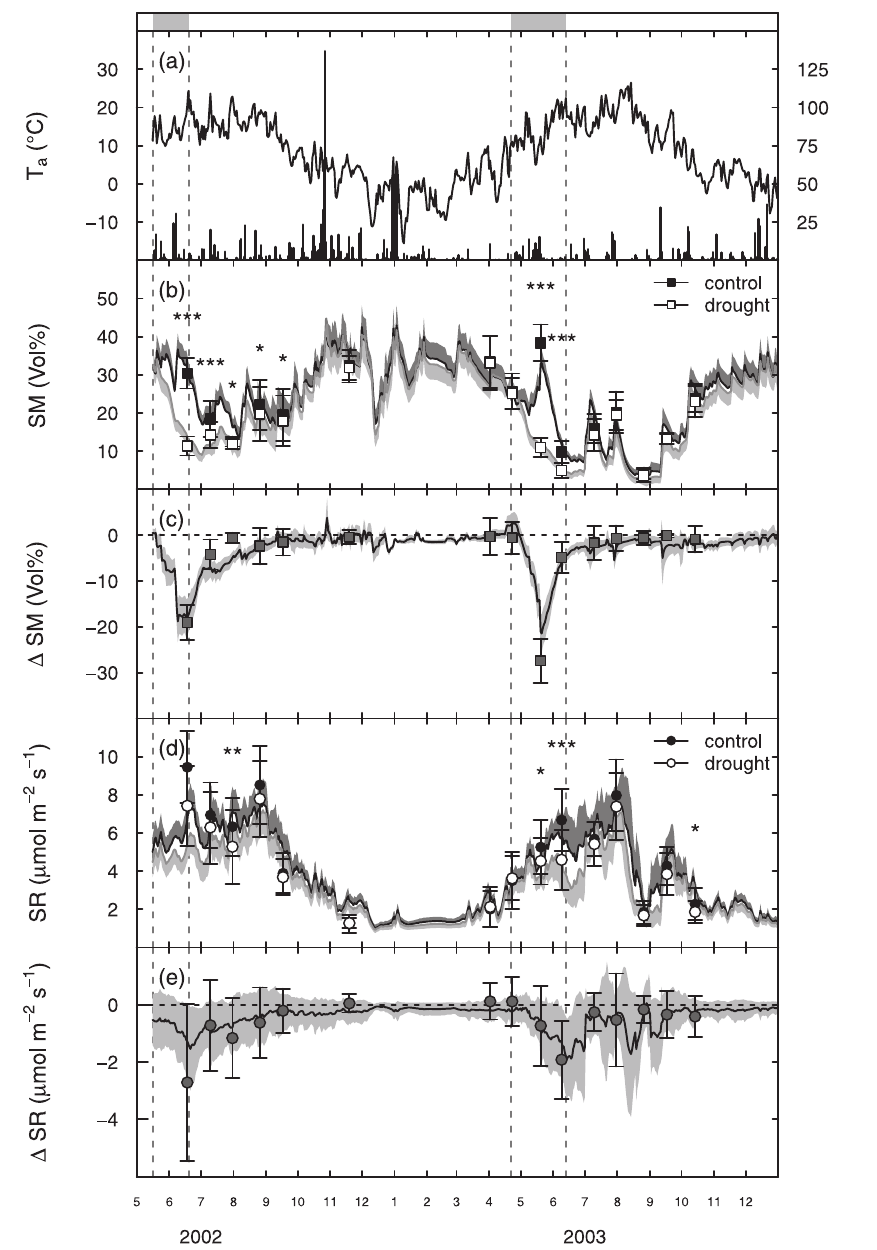
Fig 1. Measurements from May 2002 to December 2003. (a) daily mean air temperature (Ta, n = 6, from sites where data loggers were installed) and precipitation (P, daily sums of precipitation at the meteorological station Wetzstein); (b) mean manually measured soil moisture (SM), daily mean values of assimilated continuous SM (mean ± SD, n = 19) and (c) mean difference in SM between control and drought plots ( Δ SM); (d) mean manually measured soil respiration (SR), daily mean values of the modelled seasonal courses of SR (mean ± SD, n = 19) and e) the difference in SR between control and drought plots ( Δ SR). Grey rectangles in the top panel mark the shelter periods (continued by dashed lines into the lower panels). For clarity, SD is shown in one direction only. Numbers on time axis are months of the year. Stars show levels of significance: � p < 0.05, �� p < 0.01, ��� p < 0.001 (tested by